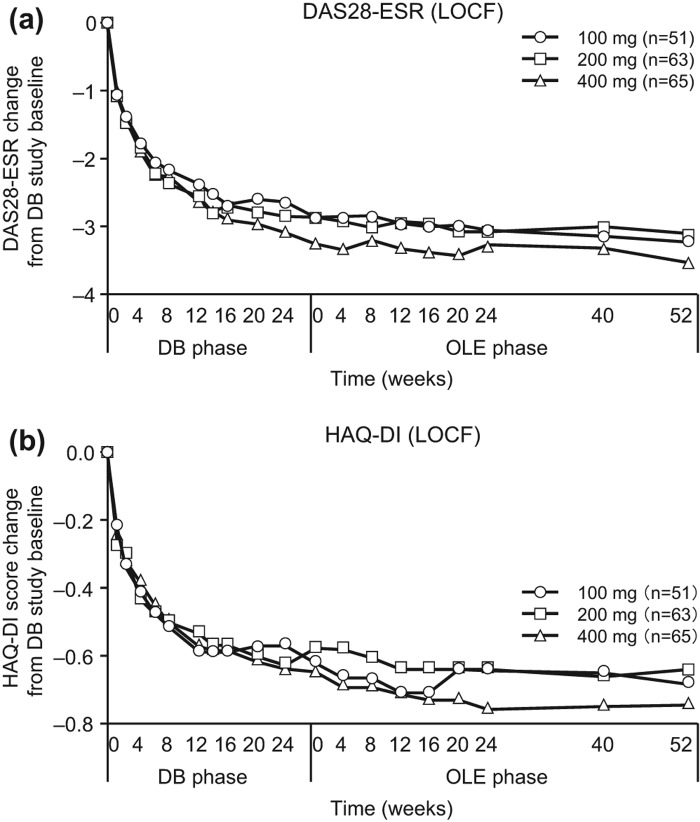
Post-hoc analysis of changes in (a) DAS28-ESR and (b) HAQ-DI scores from J-RAPID pre-study baseline in patients from Groups II, III and IV excluding those who were in the placebo group during the DB phase (CZP-DB completers). The changes of DAS28-ESR and HAQ-DI scores of post-hoc analysis patients treated with 100 mg (n = 51), 200 mg (n = 63) or 400 mg (n = 65) of CZP during the DB phase were plotted against time for the DB and the OLE phase of the study (LOCF imputation).